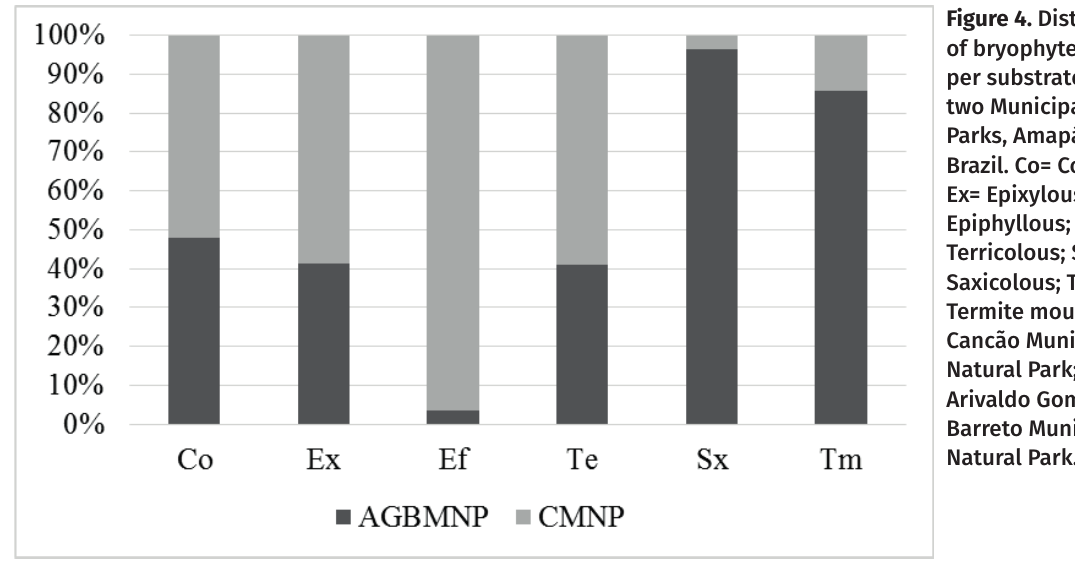
Figure 4. Distribution of bryophyte species per substrates in the two Municipal Natural Parks, Amapá state, Brazil. Co= Corticolous; Ex= Epixylous; Ef= Epiphyllous; Te= Terricolous; Sx= Saxicolous; Tm= Termite mound; CMNP= Cancão Municipal Natural Park; AGBMNP= Arivaldo Gomes Barreto Municipal Natural